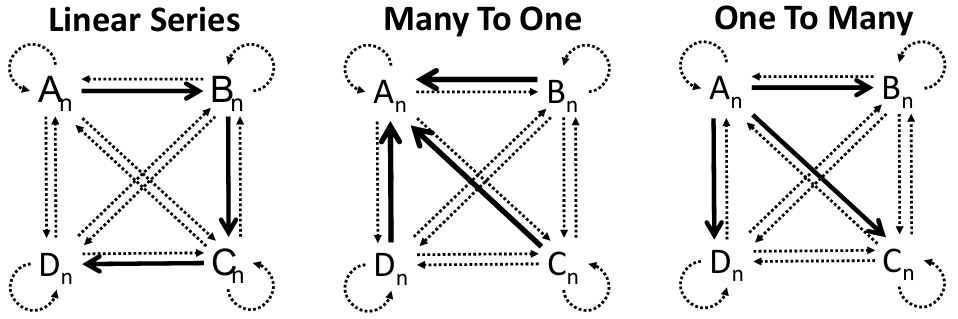
Figure 2. Members (A, B, C, and D) of the class ( n ) are trained according to the training structure, as shown by the solid arrows. The emergent relations of reflexivity, transitivity, and symmetry for the evaluation are shown as dashed